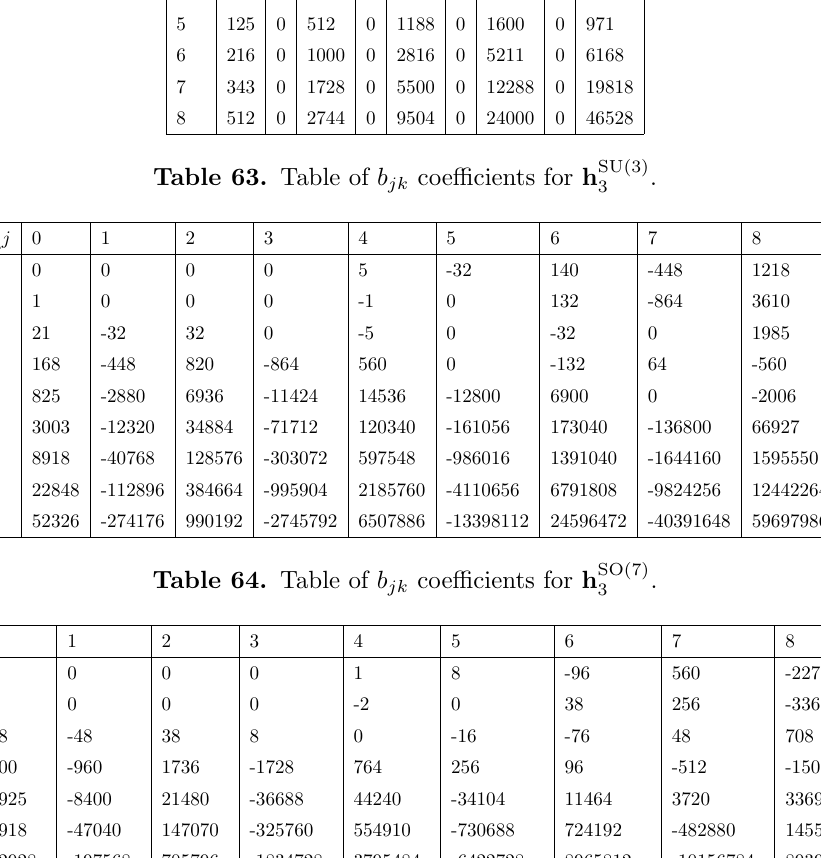
Table 65. Table of b jk coe(cid:14)cients for h SO(8)